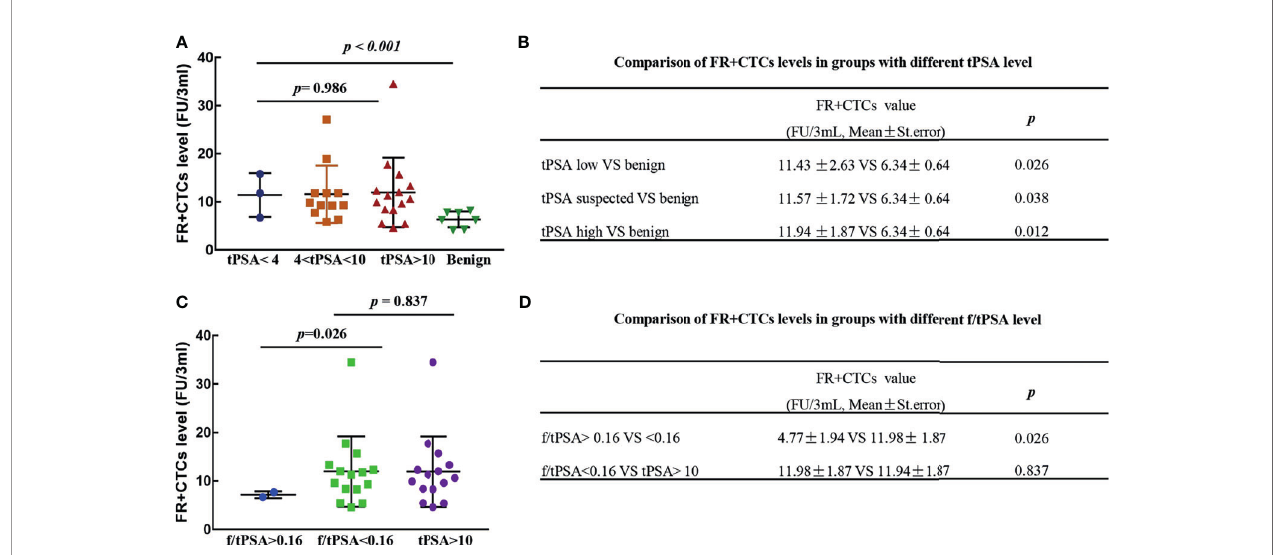
FIGURE 2 | The FR+CTCs levels in prostate cancer with different tPSA levels. (A, B) Comparison of FR+CTCs levels in patients with tPSA < 4 ng/ml, 4 ng/ml < tPSA < 10 ng/ml, tPSA > 10 ng/ml. (C, D) Comparison of FR+CTCs levels in patients with different f/tPSA